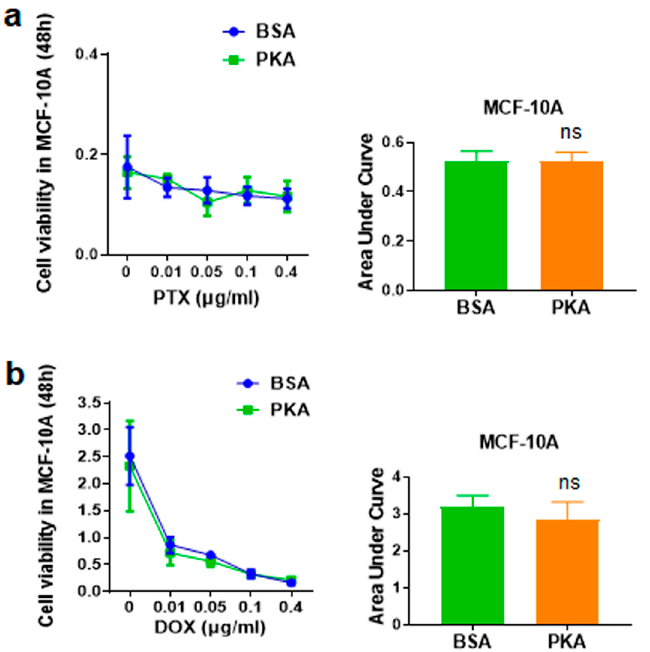
Figure 9. Cell viability results of normal breast cells MCF-10A treated with PTX or DOX following 24 h of transfection with CRISPRMAX-PKAs or CRISPRMAX-BSAs. ( a ) After 24 h of transfection with CRISPRMAX-PKAs, the MCF-10A cells were treated with PTX at 0, 0.01, 0.05, 0.1, and 0.4 µ g/mL for 48 h. ( b ) After 24 h of transfection with CRISPRMAX-PKAs, MCF-10 cells were treated with DOX at 0, 0.01, 0.05, 0.1, and 0.4 µ g/mL for 48 h; the results of AUC analyses in the PTX- or DOX-treated MCF-10A cells following 24 h of transfection with CRISPRMAX-PKAs were compared with the BSA control group ( p = 0.9619, p = 0.3410, respectively). All treatments were performed with WST-1 cell viability assays and AUC analyses. AUC analyses were used to compare the effectiveness of the drug effect between the BSA and PKA groups. Data were presented as Mean ± SD ( n = 3 replicates for transfection with the PKA and BSA group). In total, 500 ng of PKA and BSA (control) per setup was used, and the PKA group was compared with the BSA control in each setup. Statistical significances were evaluated using unpaired two-tailed t test; ns, not significant. PTX, paclitaxel; DOX, doxorubicin.